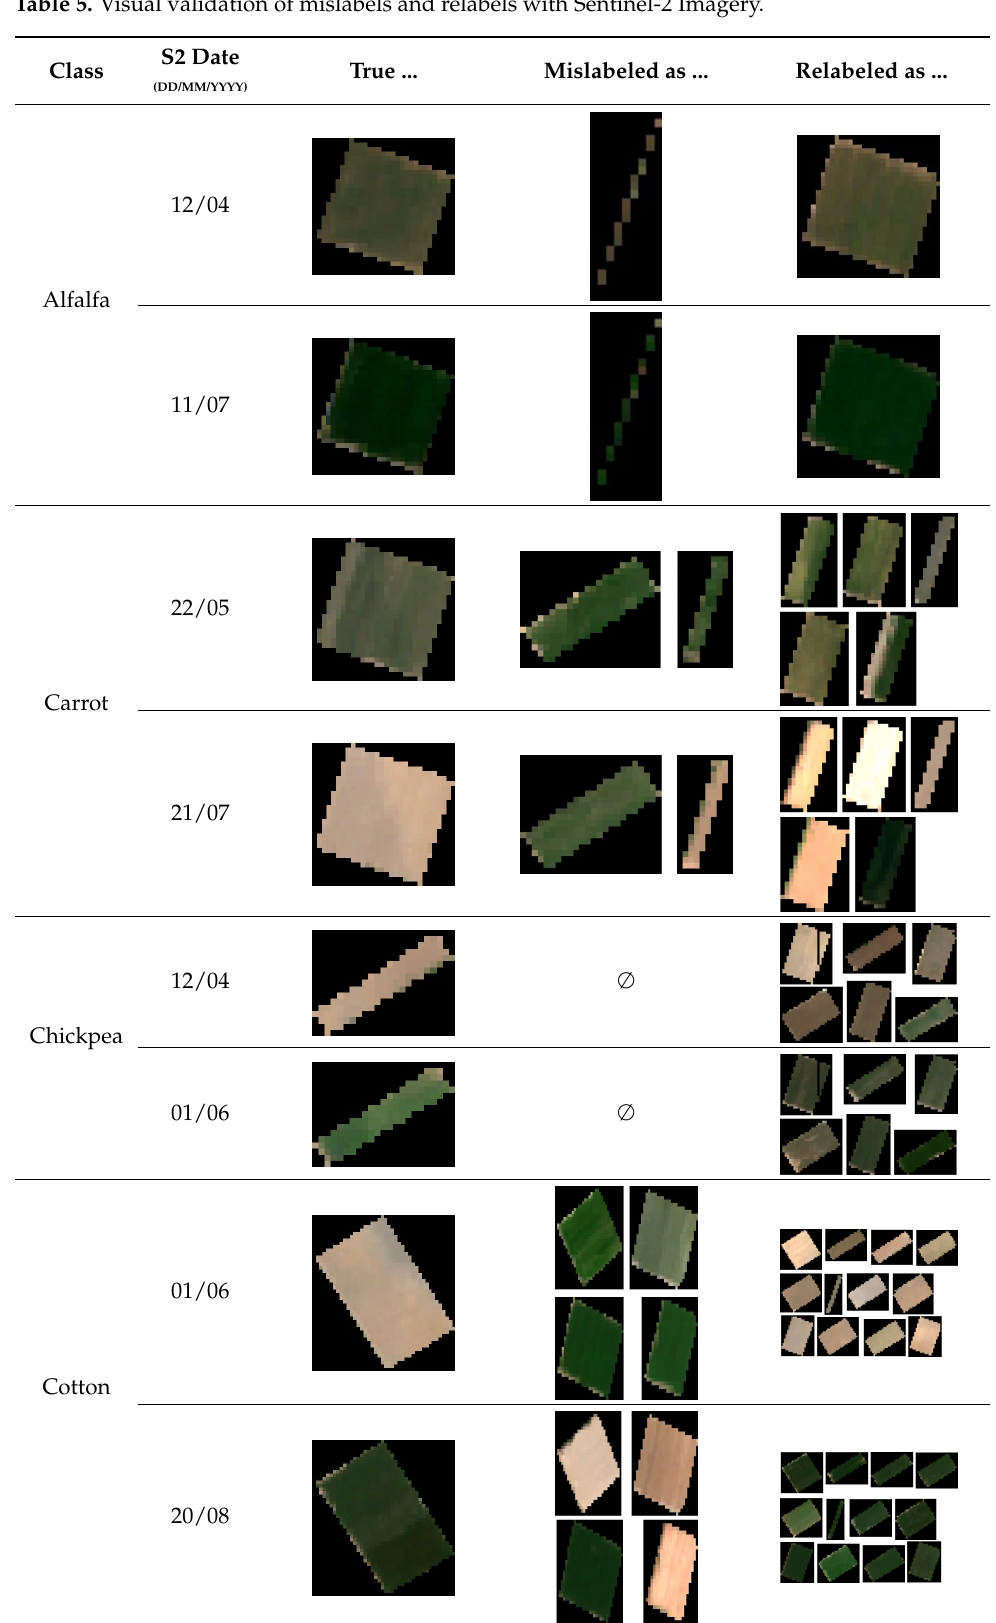
Table 5. Visual validation of mislabels and relabels with Sentinel-2